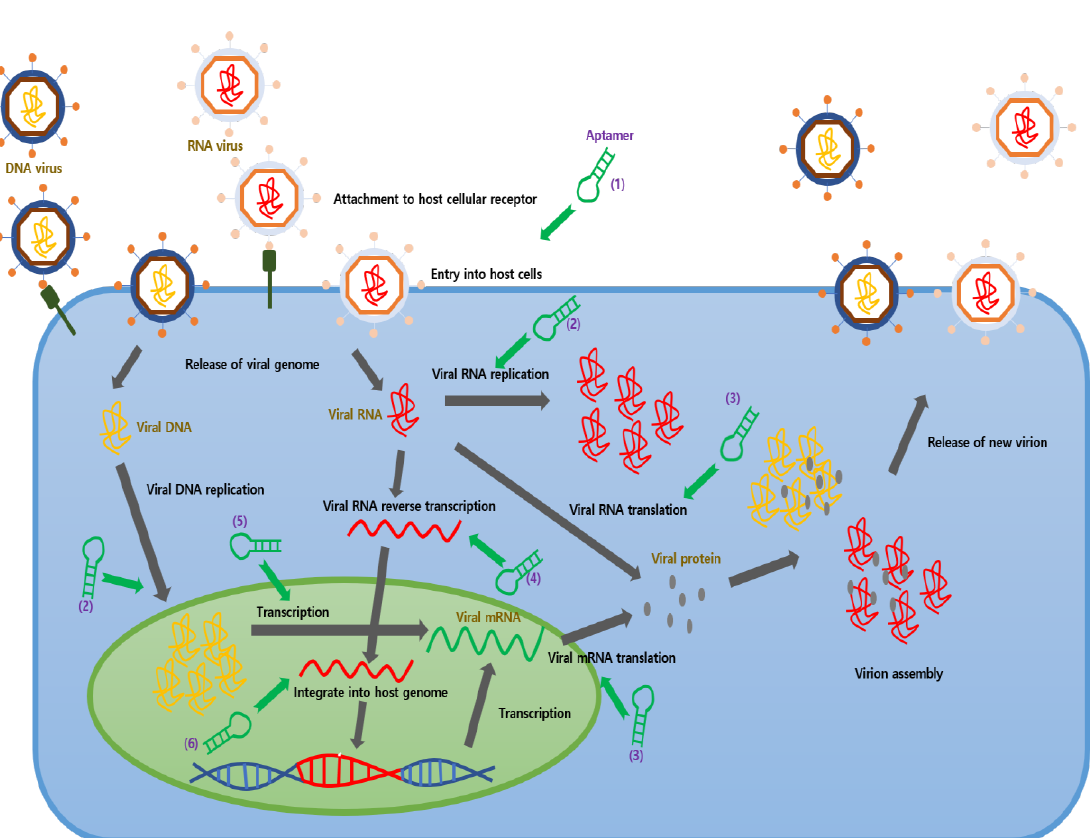
Figure 2. Scheme of viral life cycle and targets for aptamers within said cycle. The life cycle of a virus consists of attachment, entry, replication, assembly, and release. Aptamers can target factors involved in each step. (1) Aptamers can block viral entry into host cells by targeting host cell receptors or virus structural proteins. (2) Viral genome replication can be suppressed by targeting proteins such as viral polymerases and helicases. (3) Proteases, which are involved in the production of viral proteins, can be inhibited with aptamers thereby inhibiting viral replication. (4) The reverse transcription process can be prevented by targeting the reverse transcriptase involved in the RT of the viral RNA of retroviruses such as HIV. (5) Viral mRNA generation can be prevented by targeting factors involved in the transcription of the viral genome. (6) By targeting viral integrases, proviruses of viruses such as HIV can be prevented from being integrated into the genome of the host